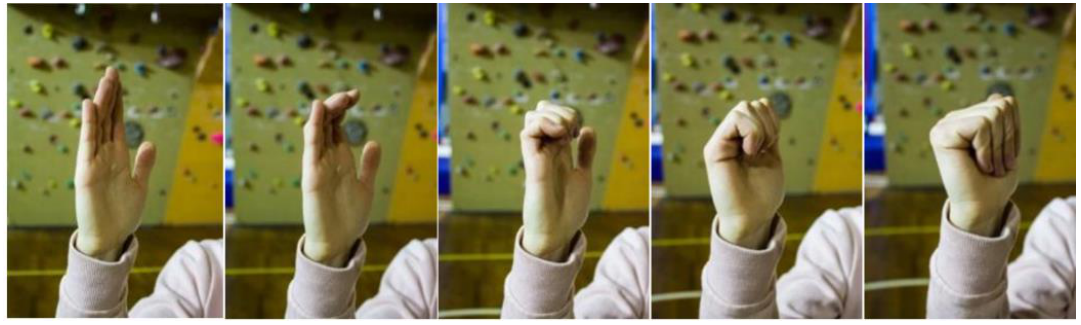
Figure 5. Flex foot and rope locked by the foot.